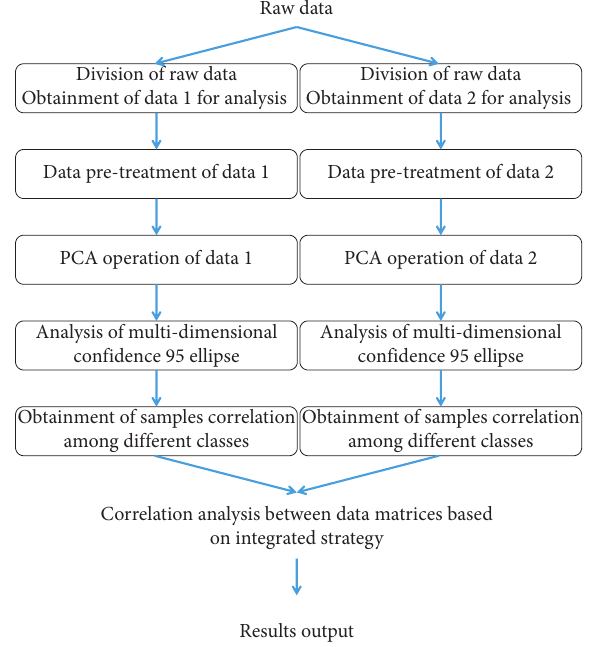
Figure 1: The flowchart of the PCA/MCEA method for data